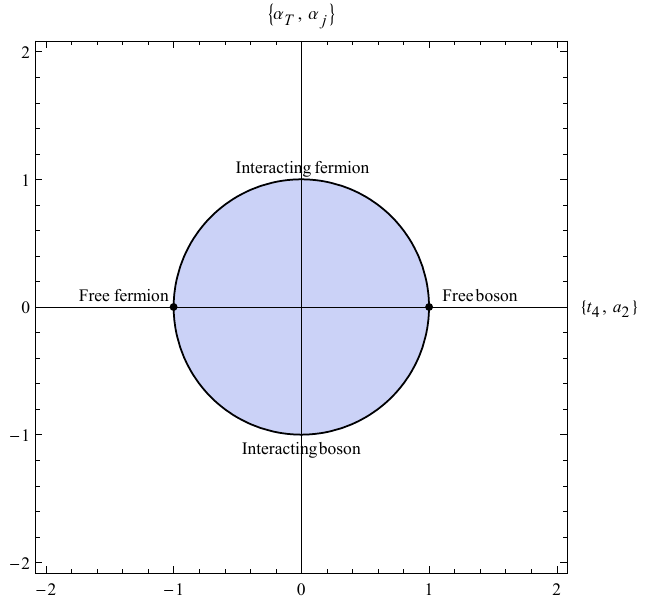
Figure 1 . The space of conformal (cid:12)eld theories in d = 3 obeying the conformal collider bounds is shaded. The y -axis denotes the parity odd coe(cid:14)cient of either the 3-pt functions h TTT i or h jjT i , the x -axis denotes the parity even coe(cid:14)cient. Large N Chern-Simons theories lie on the boundary of the disc. The position on the disc corresponds to the ’t Hooft coupling of these theories. If we choose the convention that (cid:21) is positive, the top-half circle corresponds to fundamental fermions, and the bottom half corresponds to fundamental